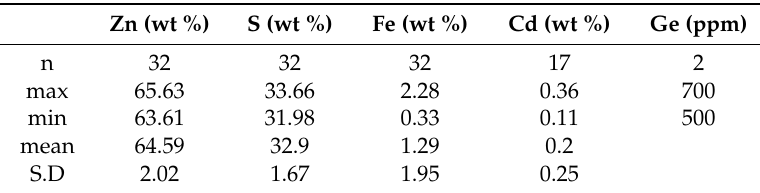
Table 1. Electron microprobe analysis (EMPA) main results of sphalerite of the Nayongzhi deposit. Minimum, maximum, mean and the corresponding standard deviation